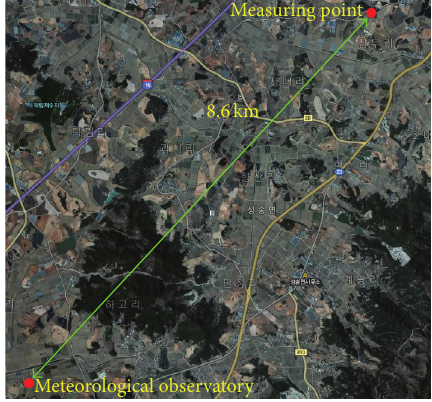
Figure 9: Distance between meteorological observatory and field-measured points.